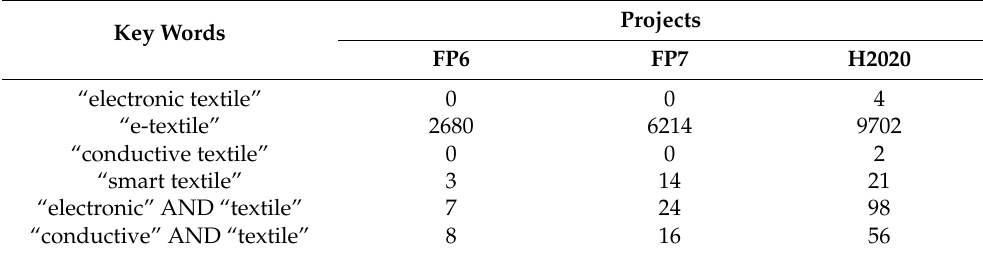
Table 1. Review of completed research projects based on selected key words and their combinations.